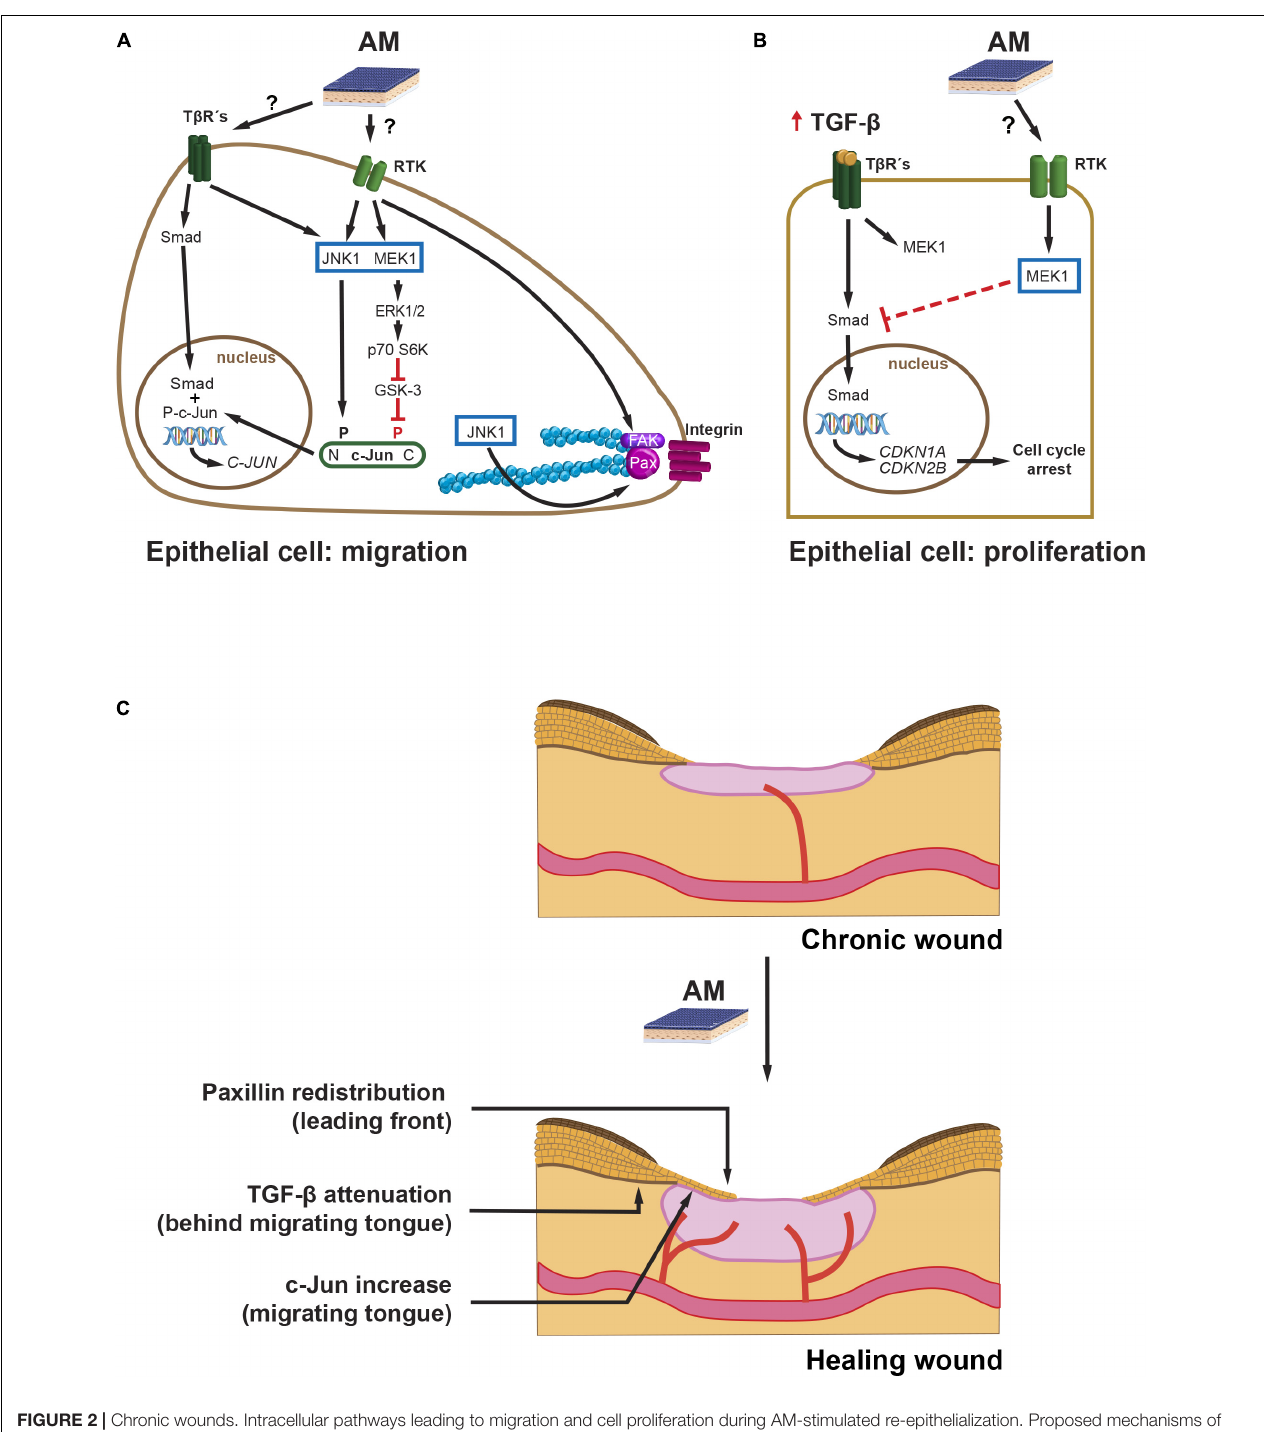
FIGURE 2 | Chronic wounds. Intracellular pathways leading to migration and cell proliferation during AM-stimulated re-epithelialization. Proposed mechanisms of action: (A) AM, possibly by secreting EGF and low levels of TGF- β , stimulates JNK1 and MEK1-ERK1/2, which leads to active c-Jun protein. N-terminus-phosphorylated, P, c-Jun, together with nuclear Smad, enhances c-Jun expression. Additionally, AM activation of JNK1 increases remodeling of FS by phosphorylation of Paxillin (Pax). Finally, the stimulation of FAK by AM can also promote cell migration. P70 S6 kinase (p70 S6K). (B) An excess of TGF- β induces the expression of cell cycle inhibitor genes: CDKN1A and CDKN2B . AM induces an attenuation of the Smad phosphorylation mediated by MEK, which prevents proper expression of CDKN1A and CDKN2B and resumes cell cycle. (C) AM proposed mechanism of action on chronic wound re-epithelialization. The effect of AM on halted chronic wound can be summarized by the re-initiation of the migrating tongue that leads to re-epithelialization by the proposed mechanisms: (i) FS remodeling by Paxillin remodeling at the leading front, (ii) overexpression of c-Jun at the migrating tongue, and (iii) attenuation of TGF- β signaling at the rear of the migrating